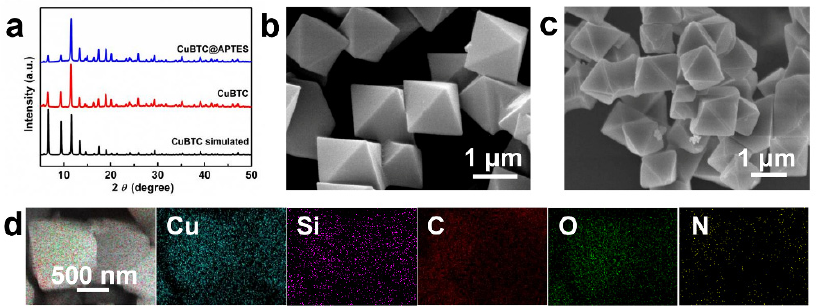
Figure 1. ( a ) XRD patterns of CuBTC and CuBTC@APTES; ( b , c ) SEM images of CuBTC and